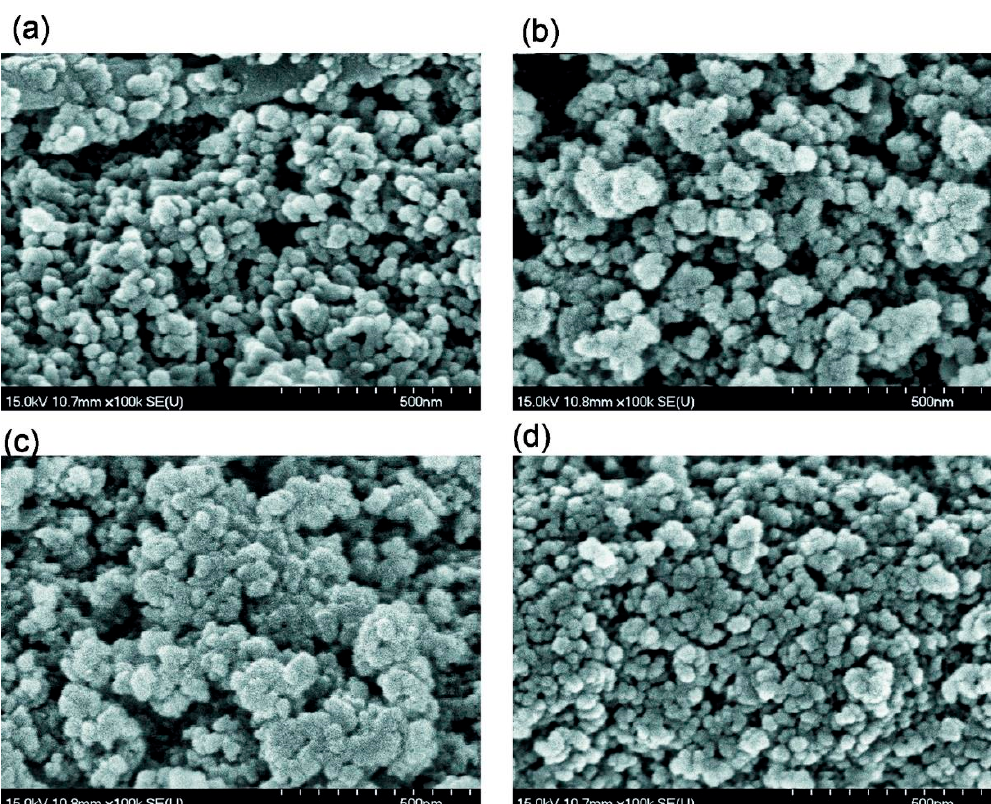
Figure. 2. SEM images of ( a ) Bl, ( b ) Bh2s, ( c ) Adl, and ( d ) Pdl (scale bar 500 nm). Figure 2. SEM images of ( a ) Bl, ( b ) Bh2s, ( c ) Adl, and ( d ) Pdl (scale bar 500